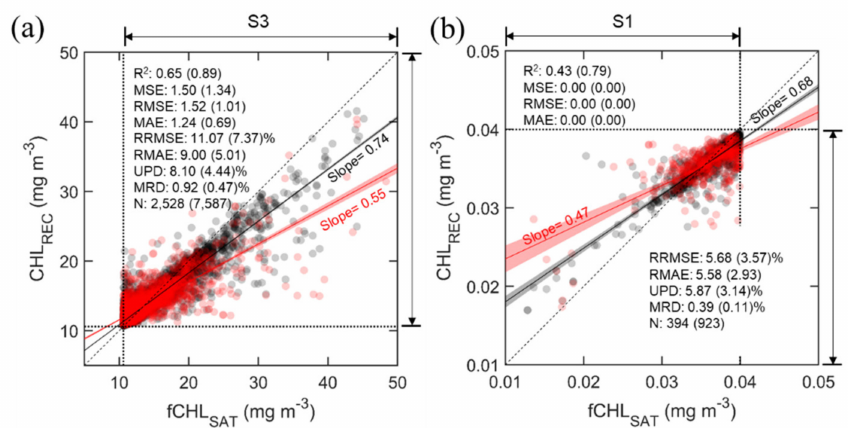
Figure 7. Scatter plots for testing the RF-model performance for insu ffi cient training data at segments ( a ) S3 (high CHL values) and ( b ) S1 (low CHL values). For this comparison, 25% of the data of each segment first were replaced by missing values, and then the model was performed. Red and black dots represent the reconstruction results for data used and not used in any model training and validation process, respectively. Ultimately, the CHL REC estimated on the replaced pixels was compared to the initial CHL values. Black and red solid lines indicate the linear regression, including 95% confidence intervals (shading). Black dotted and dashed lines are the boundary values of each segment and one-to-one correspondence, respectively. Evaluation metrics represent the accuracy for the dataset not included in model development (dataset used in model